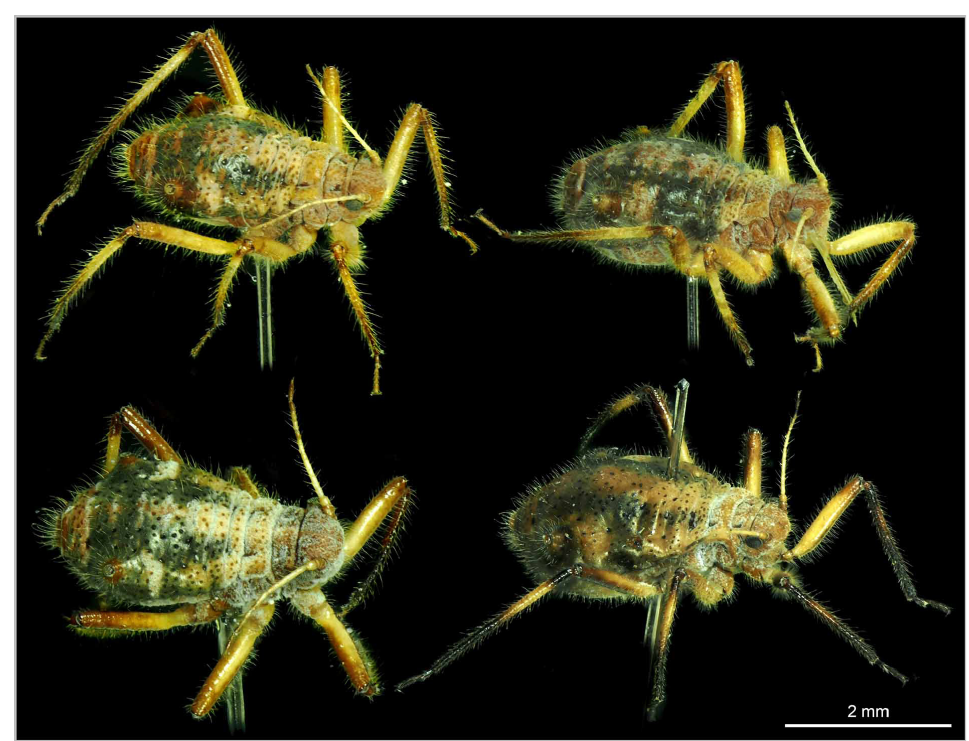
Fig. 102. Cinara (Cinara) pinea (Mordvilko, 1895). Apterae (freeze-dried specimens).